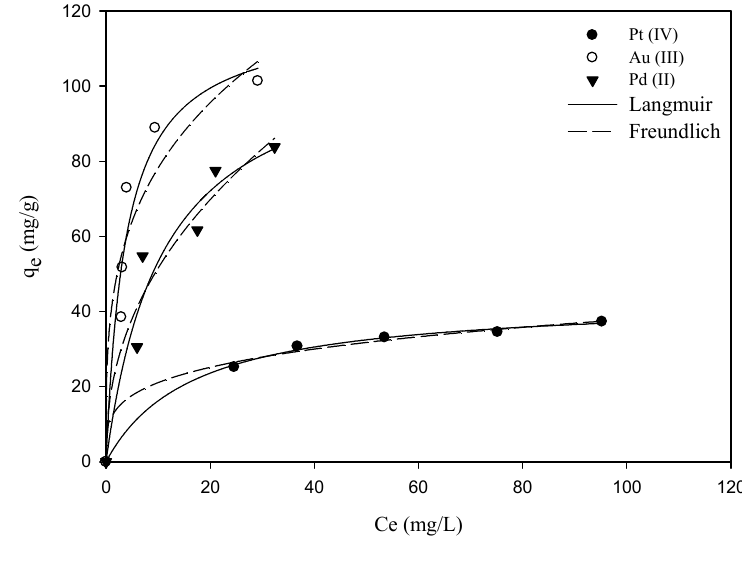
Figure 5. The adsorption isotherms of MNP-Tu for Pt(IV), Au(III) and